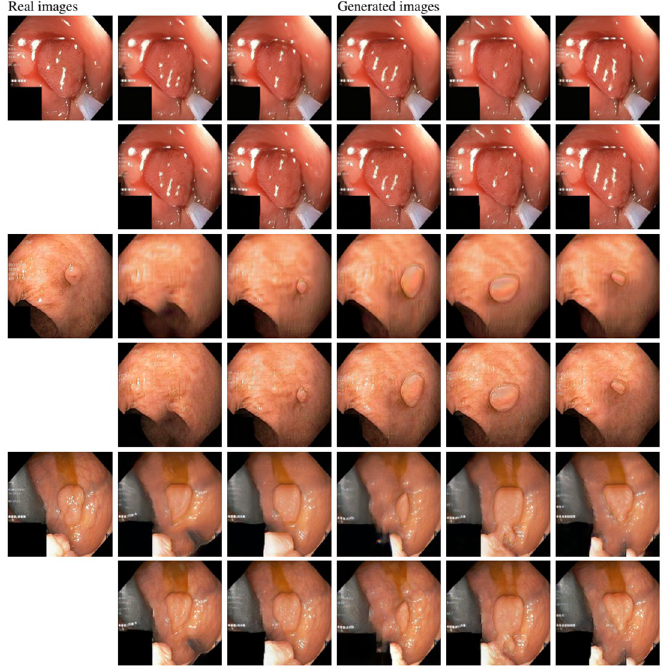
Fig 7. Direct generations of SinGAN-Seg versus style transferred samples. The style transferring was performed using 1: 1, 000 content to style ratio. The first row of generated images present quality of images before applying the style transferring and the second row of the same image shows images after applying style transferring. It can be observed that the second row with the style transferring gives better quality.